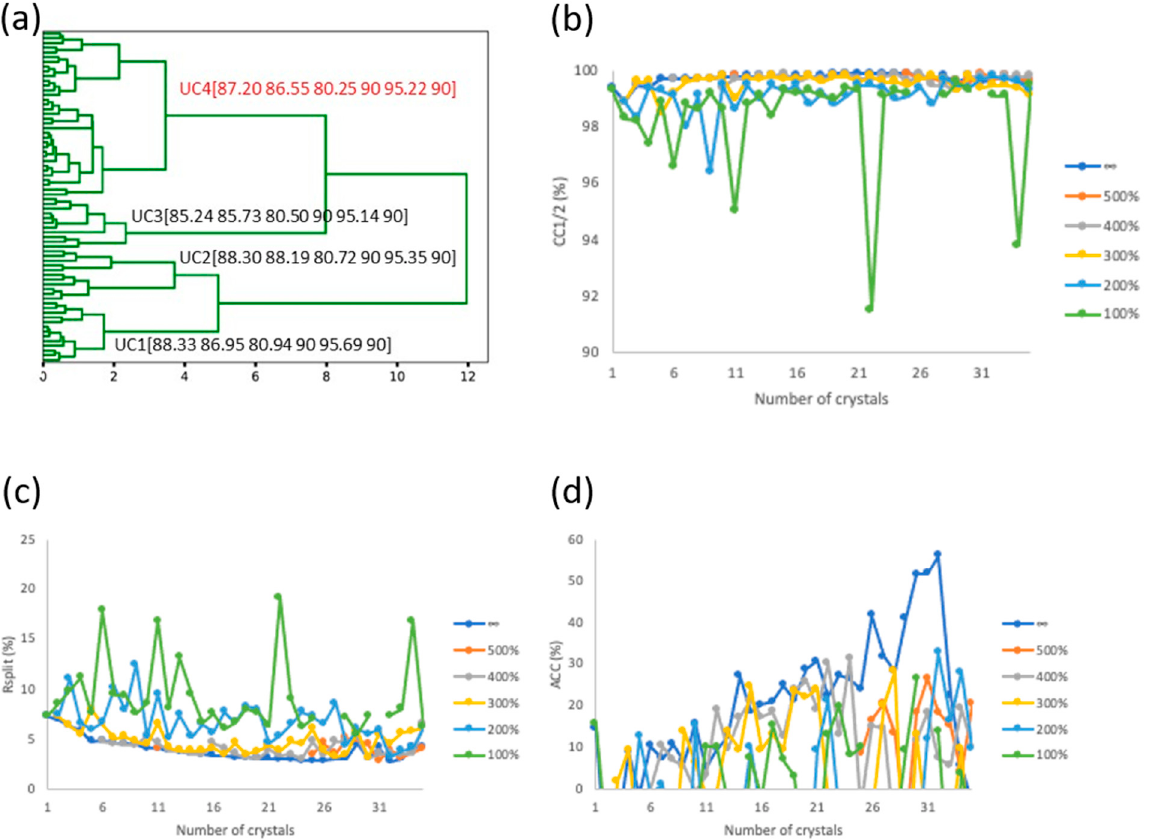
Figure 2. Data analysis of assembled LeuT data sets. ( a ) Unit-cell variation analysis for classification of single-crystal data sets. Unit-cell parameters of each cluster are shown. ( b – d ) Data assembly and subsequent crystal and frame rejections were performed by using PyMDA as described in the methods: ∞ , no frame rejection and 500–100%, where 100% is the most stringent rejection. ( b ) CC1/2 at 4 Å d min . ( c ) Rsplit at 4 Å d min . ( d ) Anomalous correlation coefficient (ACC) at 10 Å d min .